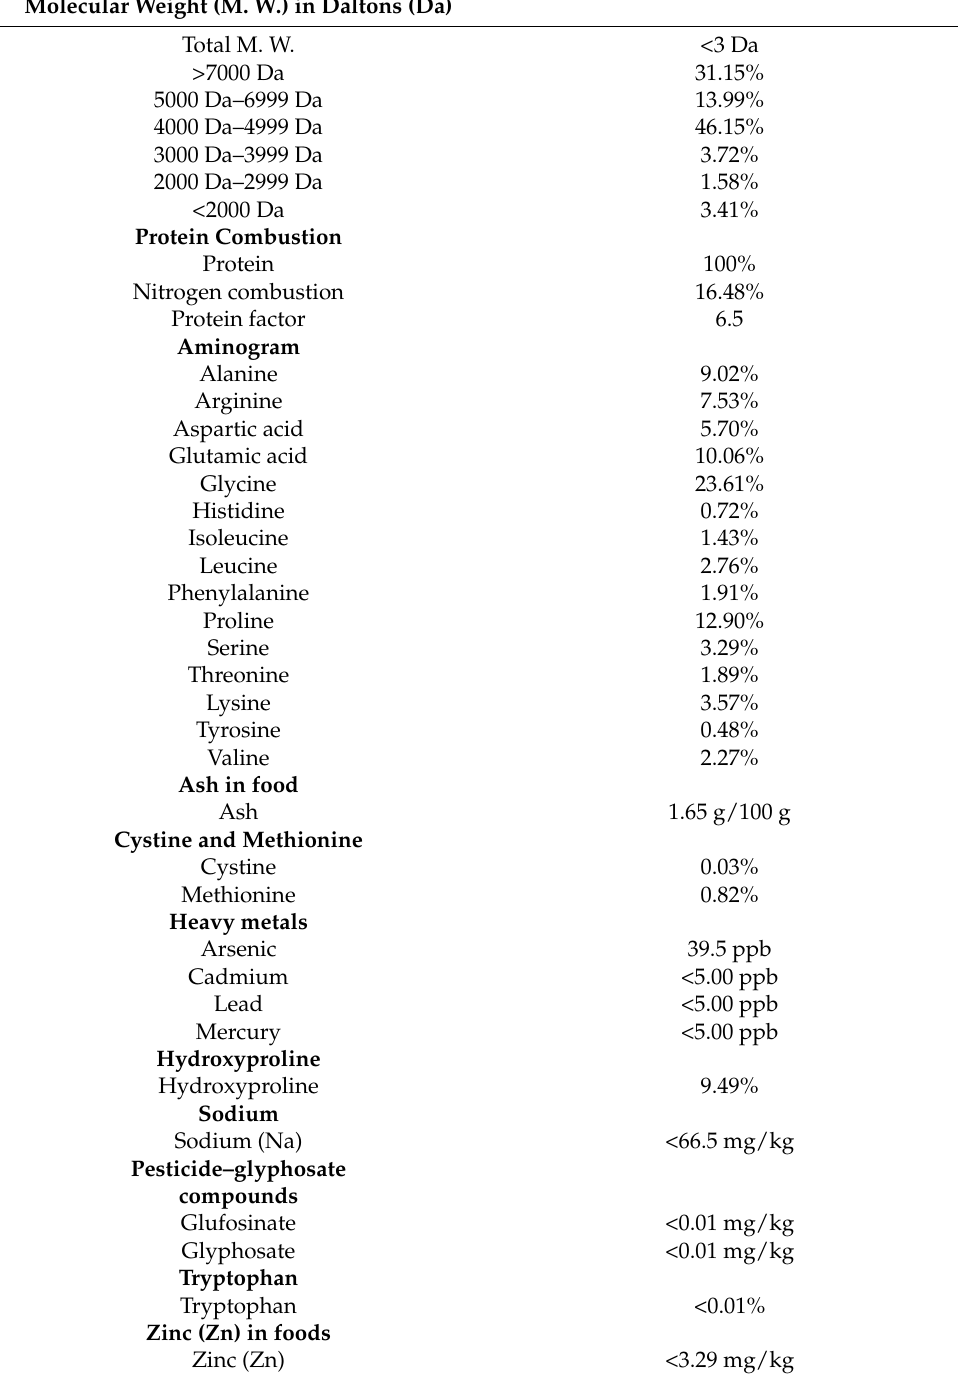
Table 1. Molecular, physicochemical, and microbiological characteristics of the PeptPure ® colla- gen